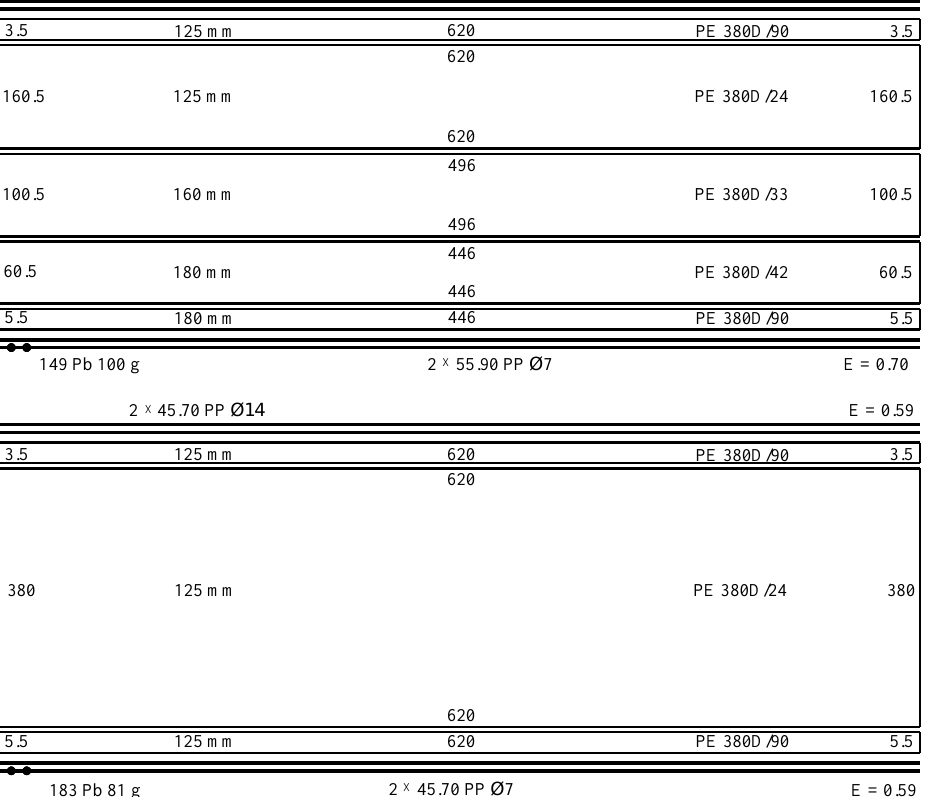
Figure 2. Schematic representation of the experimental (top panel) and control (bottom panel) gillnets tested during the fishing trials. Pb—Plumbum is lead; PP and PE are polypropylene and polyethylene, respectively; Ø is diameter; D is denier; and E is hanging ratio.